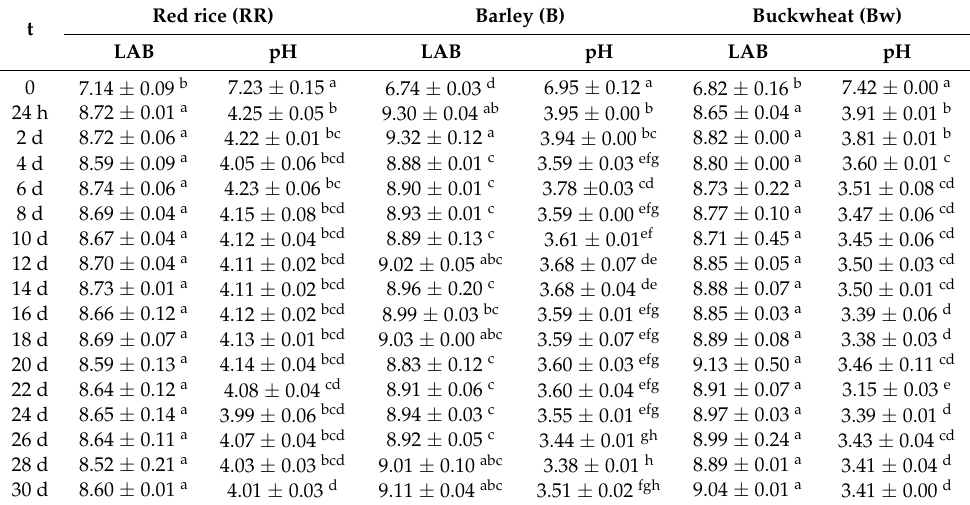
Table 4. Viable counts of lactic acid bacteria on Man, Rogosa and Sharpe (MRS) agar incubated at 37 ◦ C, expressed as Log colony forming units (cfu) mL − 1 , and pH values assessed in the laboratory- scale prototypes of fermented beverages made with red rice, barley and buckwheat immediately after inoculation (t 0 ), 24 h fermentation, and every 2 days during the 30 day-shelf life under refrigerated conditions (+4 ◦ C) (from t 2 to t 30 ). Red rice